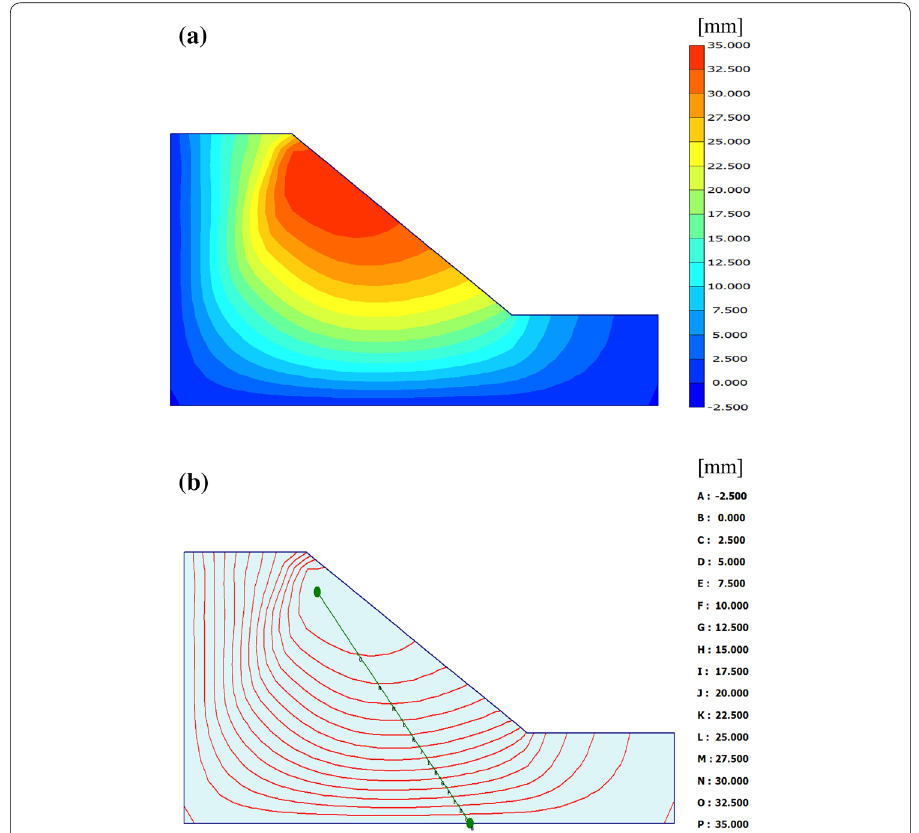
Fig. 15 Plot of horizontal displacements at β